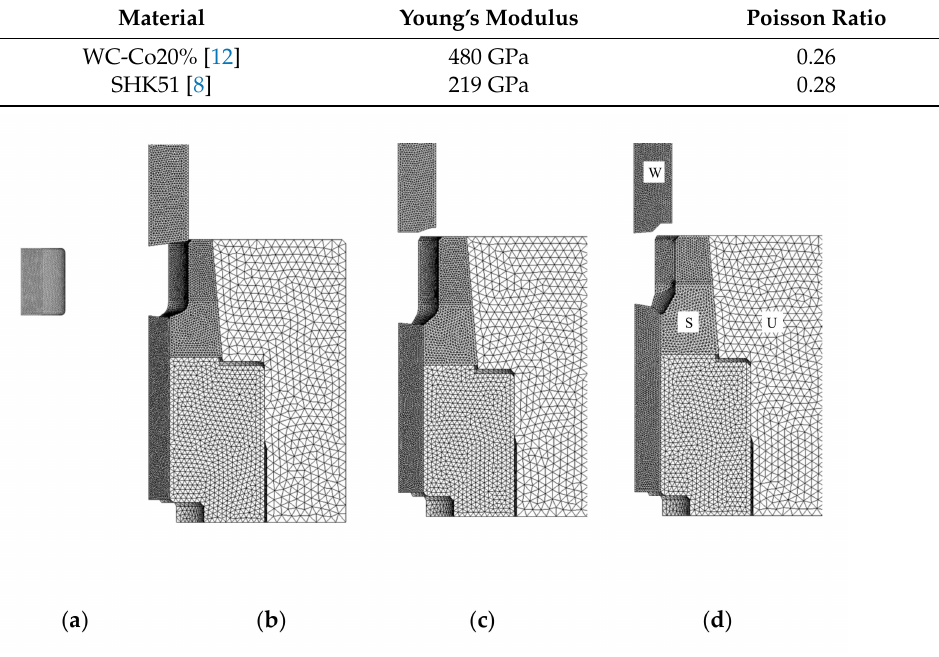
Figure 3. Typical finite element mesh systems of the material and the selected die parts marked by letters S, U and W in Figure 1: ( a ) workpiece; ( b ) stage 1; ( c ) stage 2; ( d ) stage